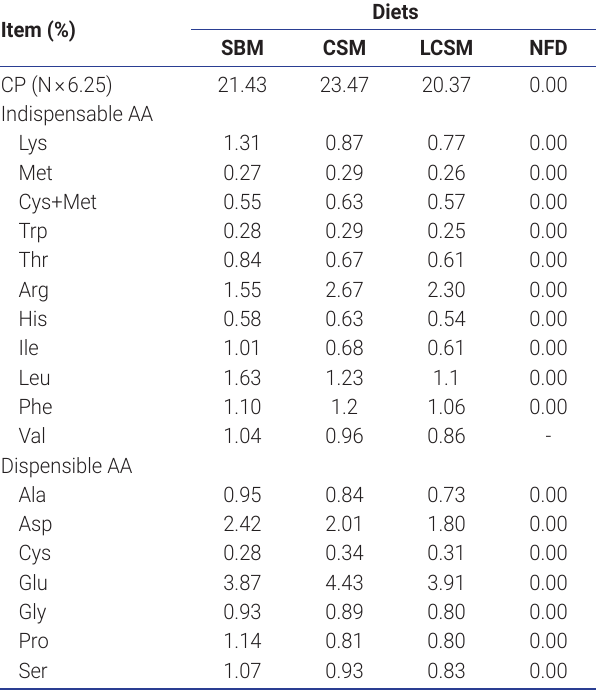
Table 4. Analyzed nutrient content of experimental diets, as-fed basis